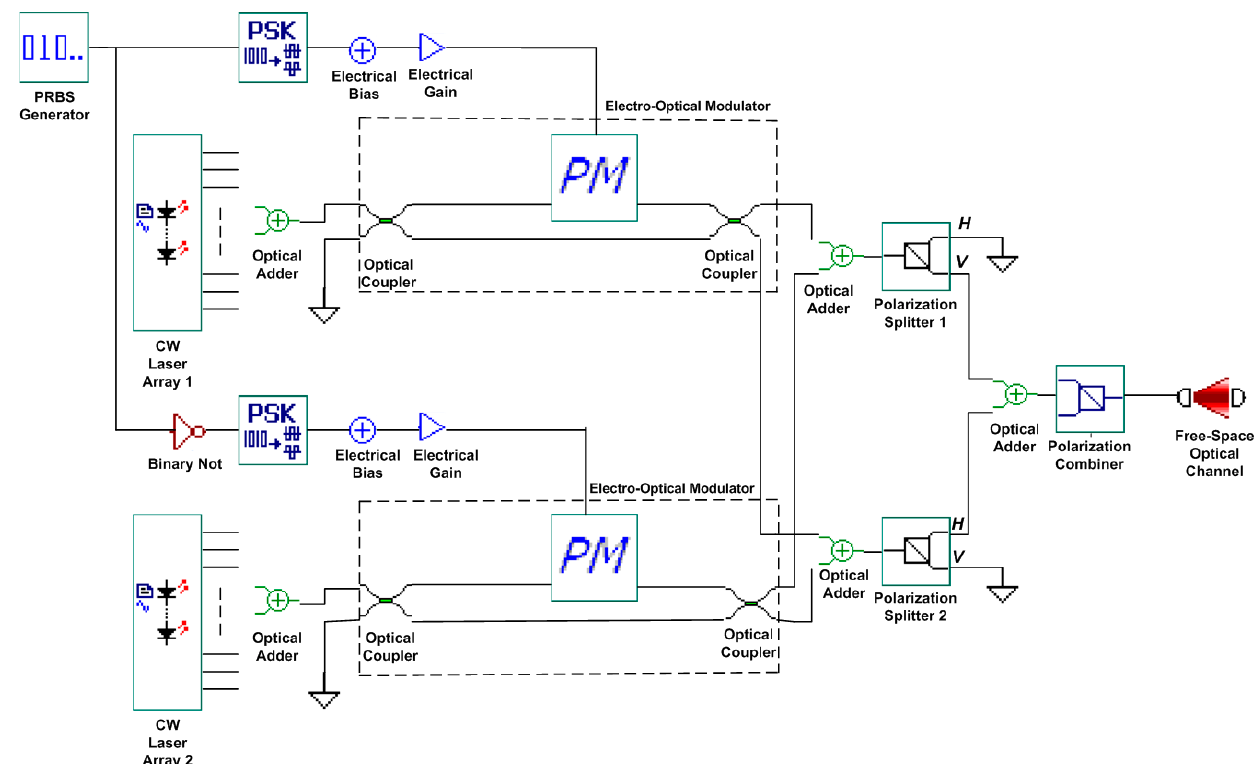
Figure 1. Proposed Bi ‐ OCDMA encoder.